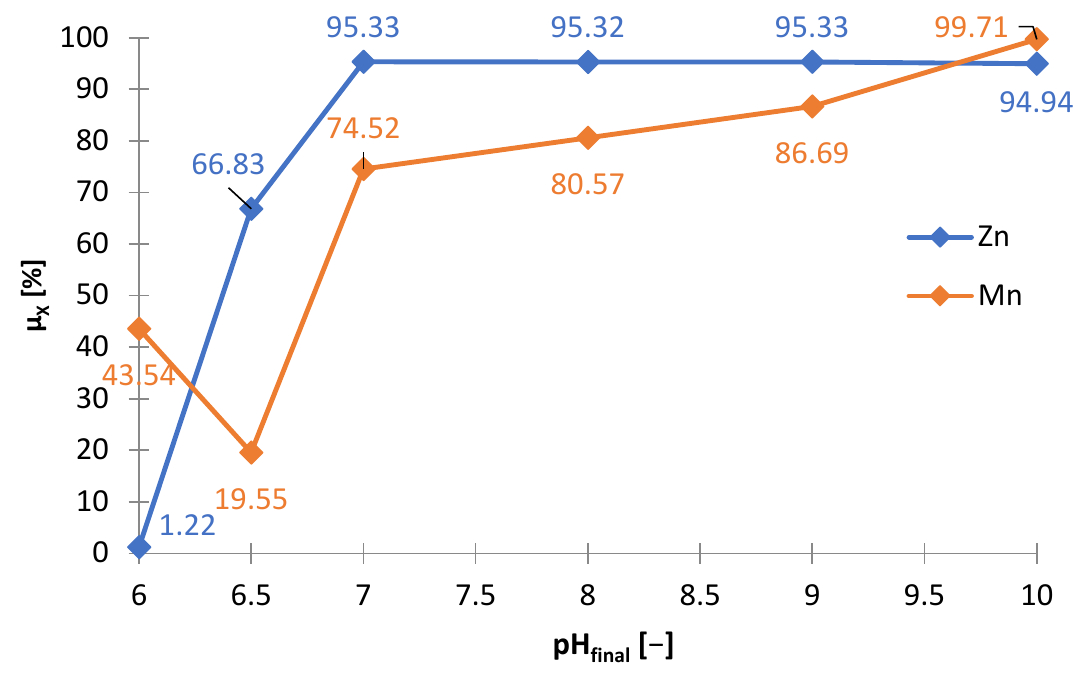
Figure 28. Effect of on final pH (pH final ) on amount of precipitate ( ∆ m prec /V sol ) during precipitation by using Na 2 CO 3 from solution after selective leaching.